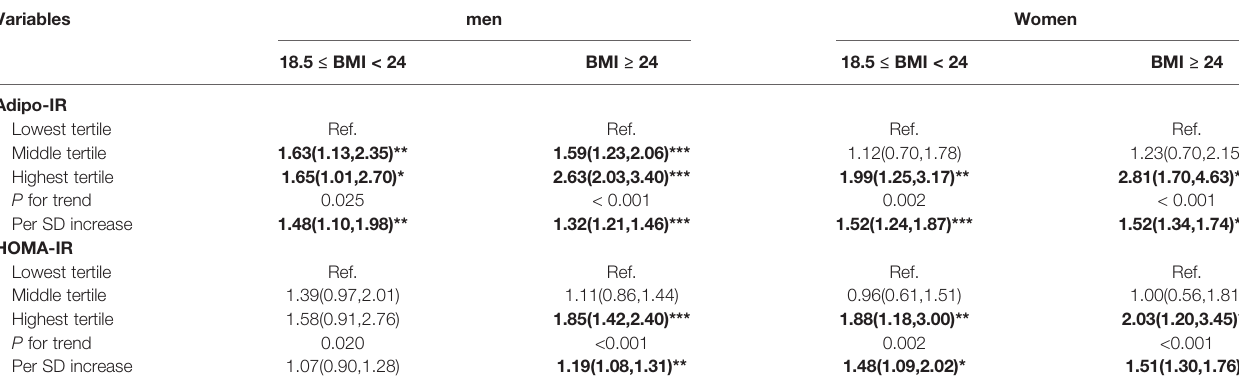
TABLE 4 | Logistic regression analysis for association between Adipo-IR or HOMA-IR and hyperuricemia in both normal BMI and elevated BMI subgroups.